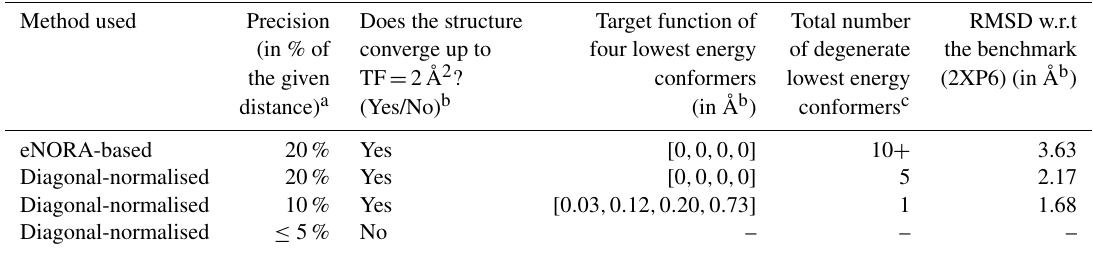
Figure 1. Left: distances extracted from F1-[ 15 N, 13 C]-filtered [ 1 H, 1 H] NOESY using the eNOE (blue) and diagonal-normalised approach (red) compared to the benchmark X-ray structure. The bars denote the distances that arise from the cross-relaxation rates from the complex of PIN1 with Compound 2, as given in Torres et al. (2020). The bars in yellow represent the distances back-calculated from the X-ray structure (2XP6) (Potter et al., 2010). The error bars denote the upper and lower limit restraints produced in CYANA (Güntert and Buchner, 2015) for the extracted distances. A tolerance of 20% and 10% was taken and for the eNOE and the diagonal-normalised approach extracted distances respectively. Right: the ratio of NOE build-ups to the corresponding diagonal peak intensities plotted against mixing time for the PIN1–Compound 2 complex for the diagonal-normalised approach. The data points were fitted using a linear least square fitting model in MATLAB (MATLAB, 2018). The slope denotes the cross-relaxation rate of the given peak, as per Eq. (5). Table 1. Table detailing the results of N MR 2 calculations with distance restraints extracted from eNOE and diagonal-normalised method with varying values of errUni in CYANA. Method used Precision Does the structure Target function of Total number RMSD